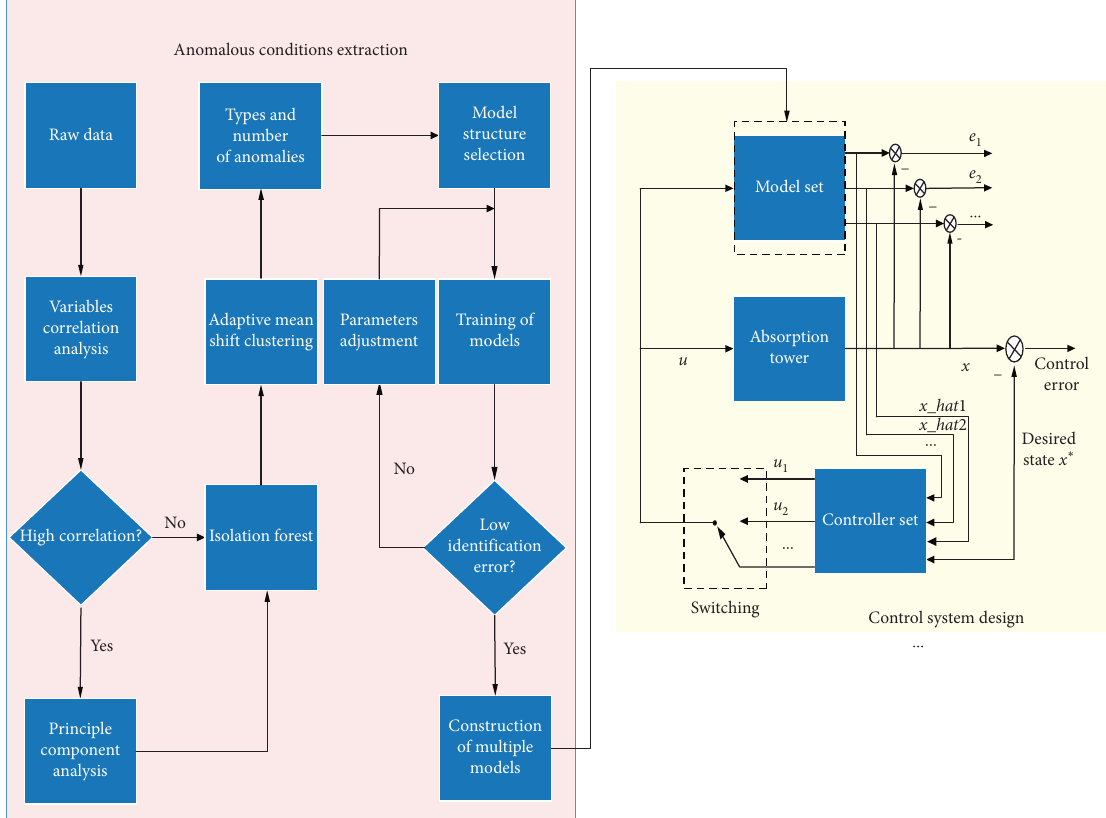
Figure 9: Scheme of the complete control